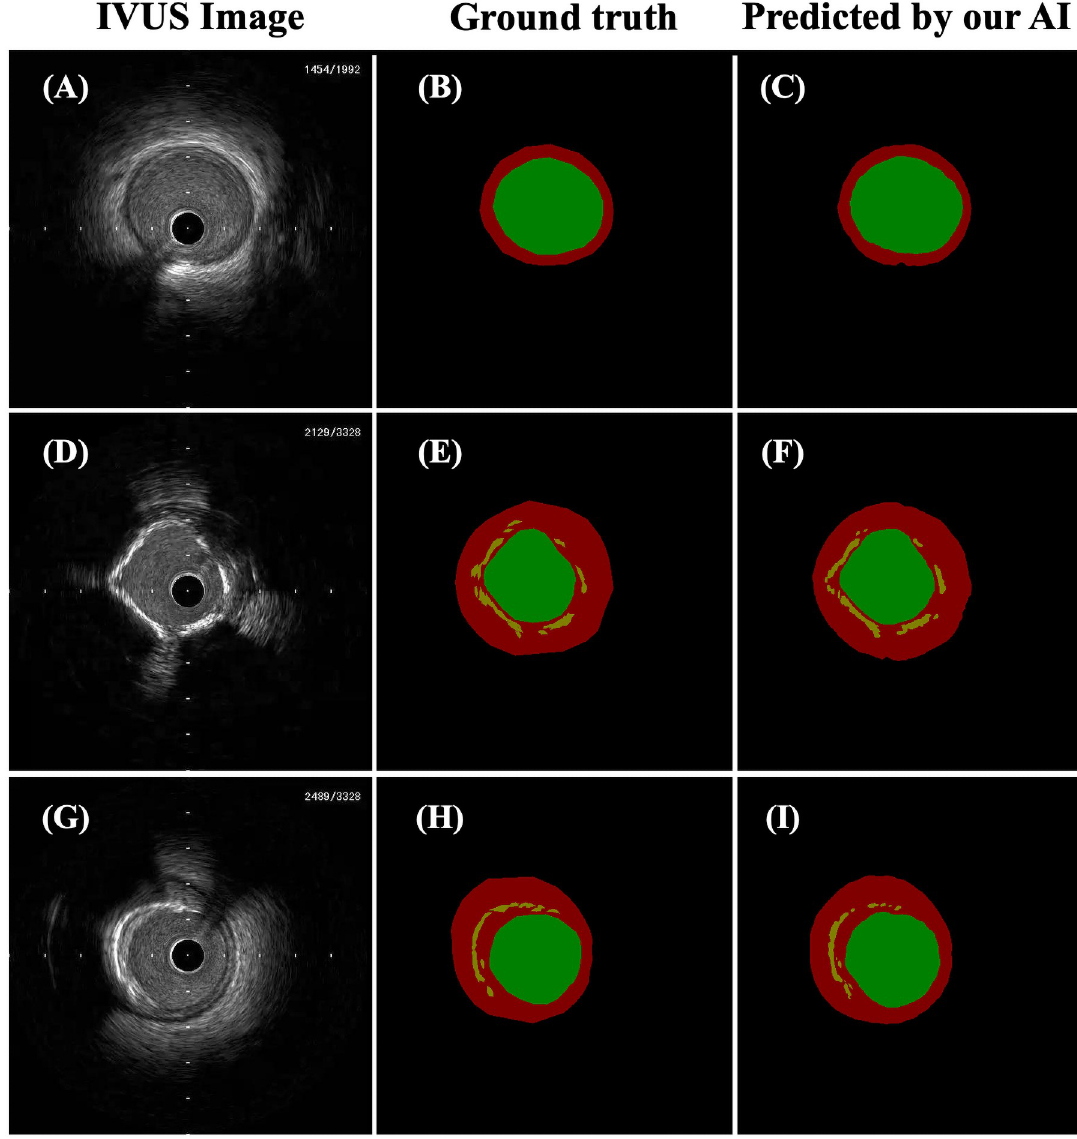
Fig 5. Representative images of cases successfully predicted by our AI. The panels on the left (A, D, G) show IVUS images. The middle panels (B, E, H) show ground truth mask images that were manually segmented corresponding to IVUS images on the left in the same row. The panels on the right (C, F, I) show mask images predicted by our AI corresponding to IVUS images on the left in the same row. In the mask images, the green area shows the lumen area, the red area shows the medial plus plaque area, the orange area shows calcification, and the black area is background. Calcifications in the IVUS images were effectively segmented by our AI (F,